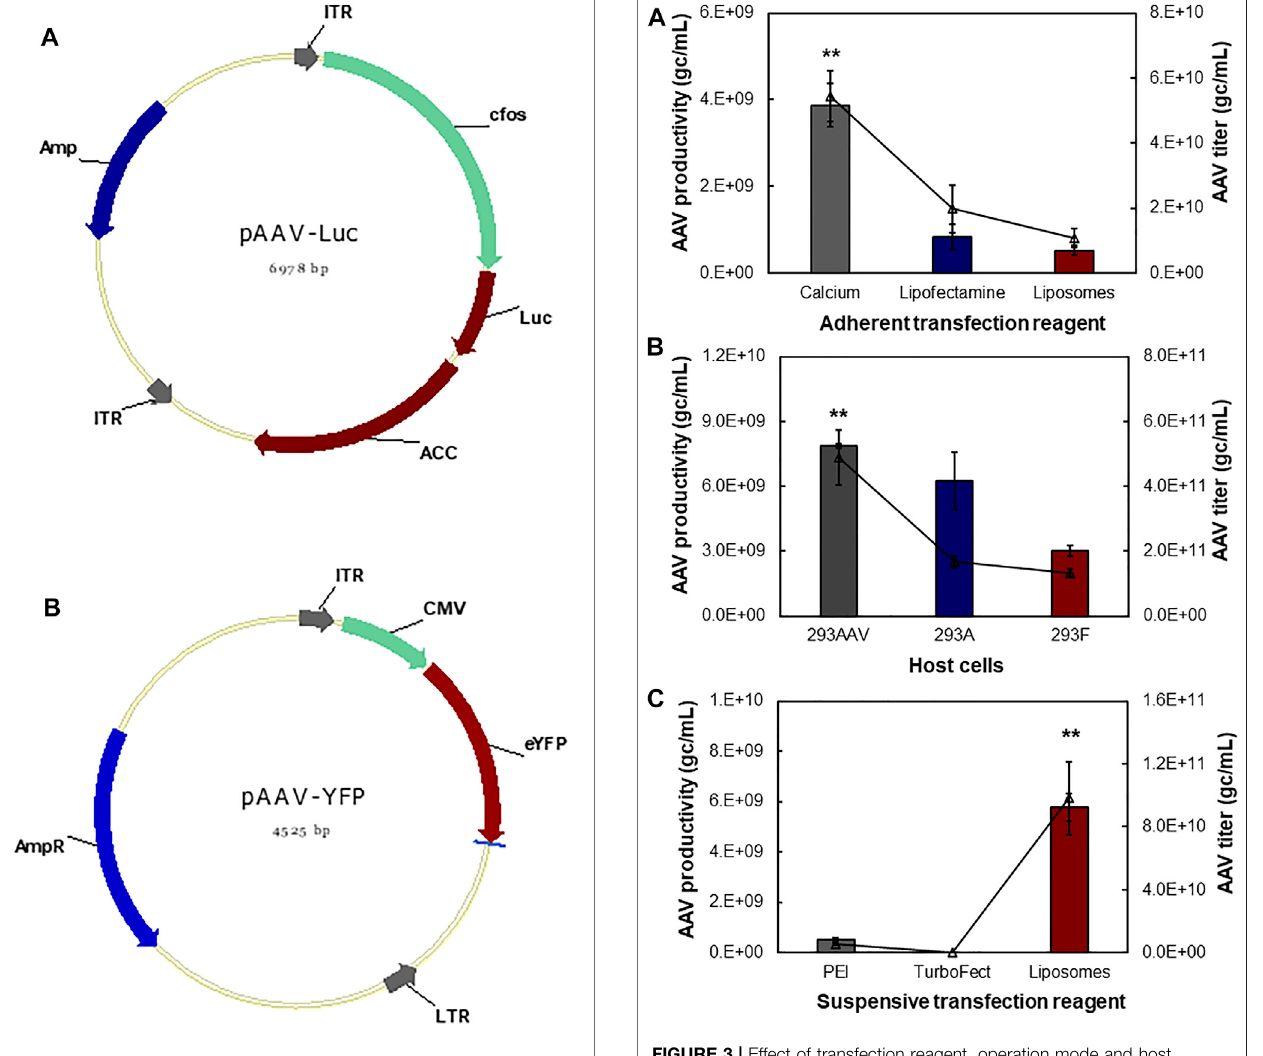
FIGURE 2 | pAAV plasmid maps. (A) The plasmid map of pAAV-cfos- NLuc-ACCcontainingcfospromoterandNLucreportergeneandfusedgene, total of 6.978 kb. (B) The plasmid map of pAAV-cMV-eYFP containing CMV promoter and YFP reporter gene, total of 4.525 kb.